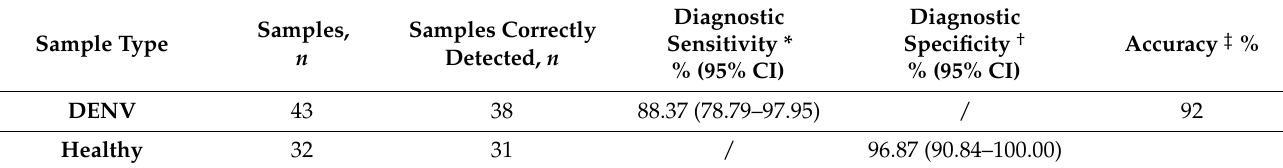
Table 1. Molecular MFEA readout on biological